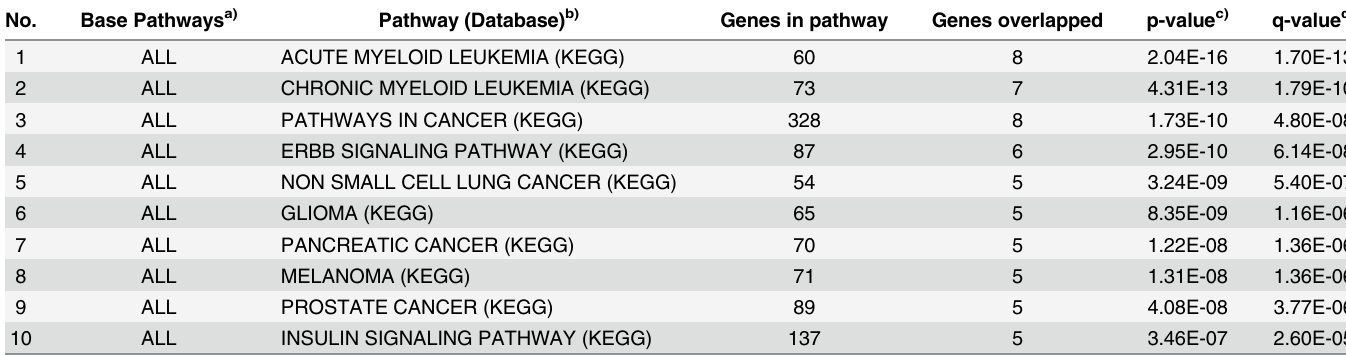
Table 2. Enrichment analysis results using RPNI